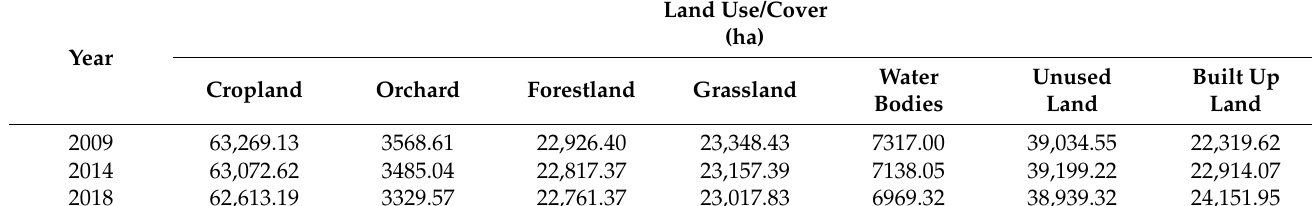
Table 1. Land use change of Wu’an City from 2009 to 2018.